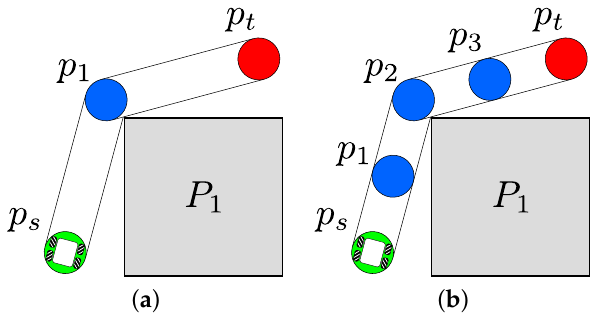
Figure 3. Multimodality in the path-planning problem: ( a ) a path with minimum length and a minimum number of control points and ( b ) the same path using more control points.